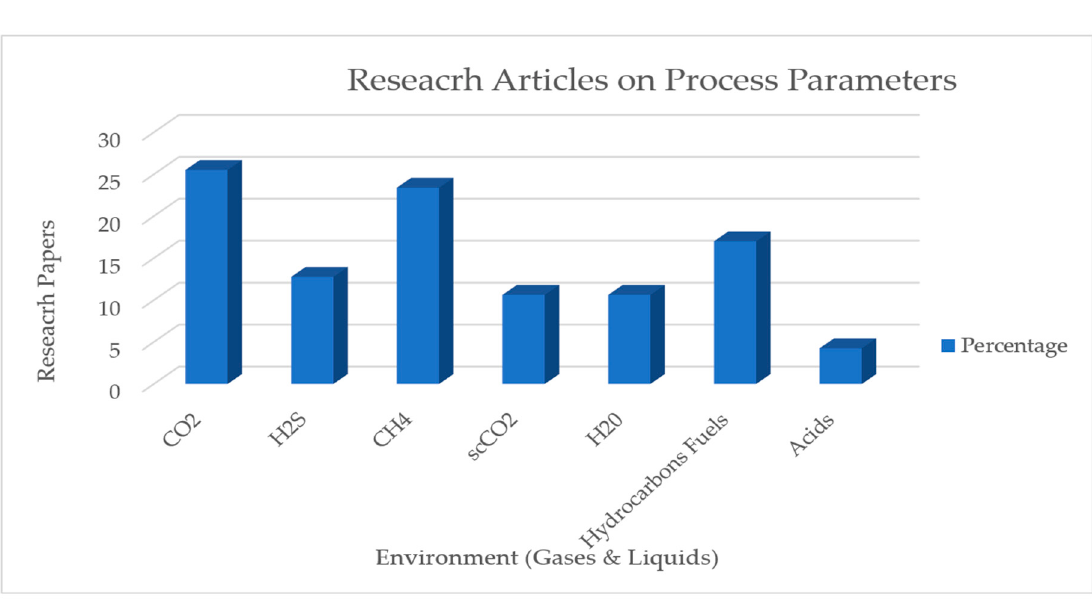
Figure 5. Different types of gases and fluids used in permeation experiments. Figure 5. Di ff erent types of gases and fluids used in permeation